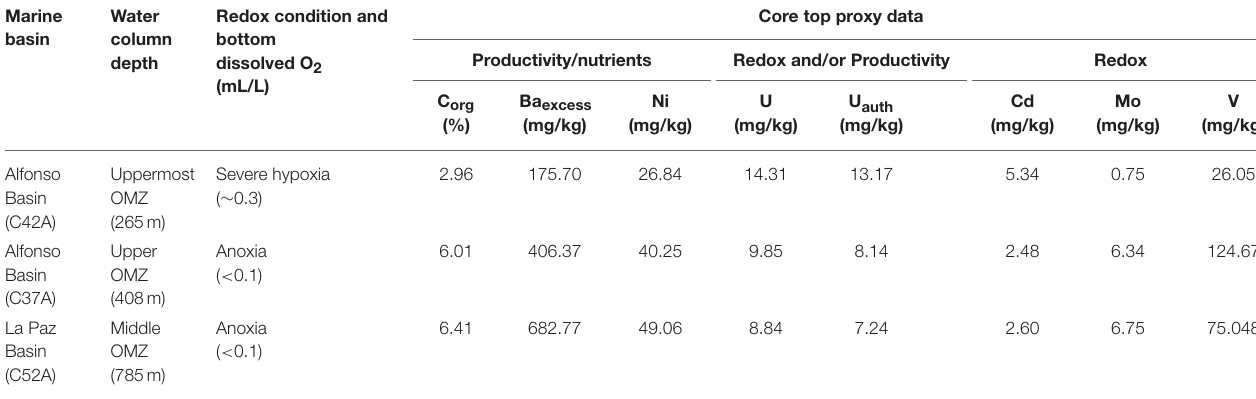
TABLE 2 | Composition of modern sedimentary material represented by core tops from different OMZ depths in Alfonso (C42A and C37A) and La Paz basin (C52A).